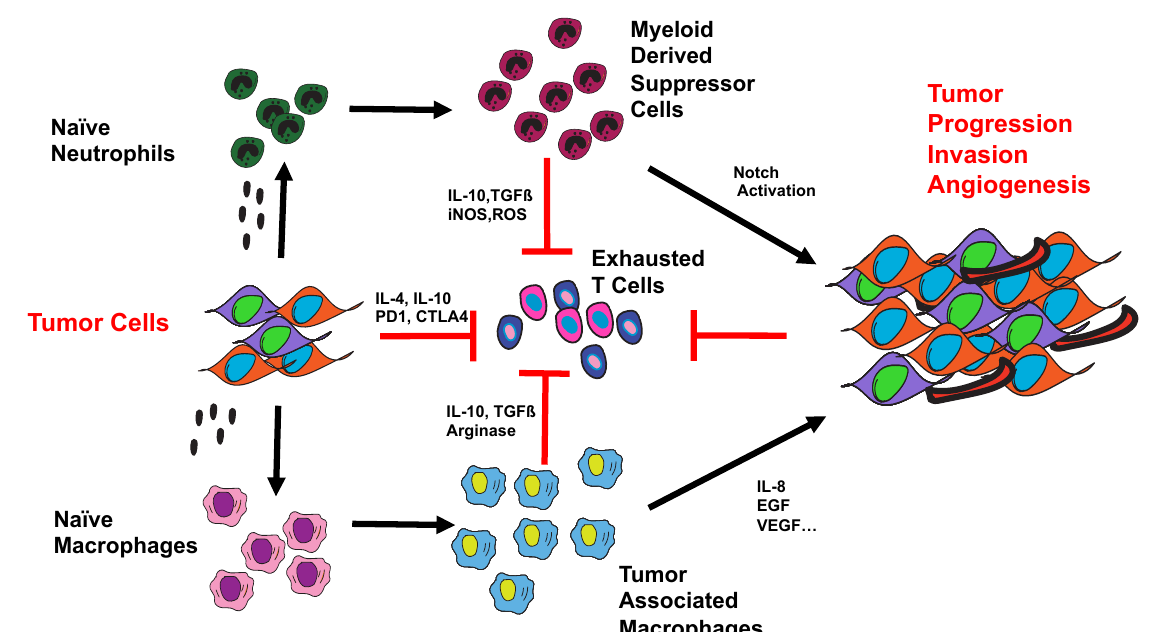
Figure 2. TAMs and tumor-infiltrating neutrophils (TINs) can promote tumor progression and metastasis by inhibiting anti-tumor T cells and promoting the survival of tumor-initiating cells